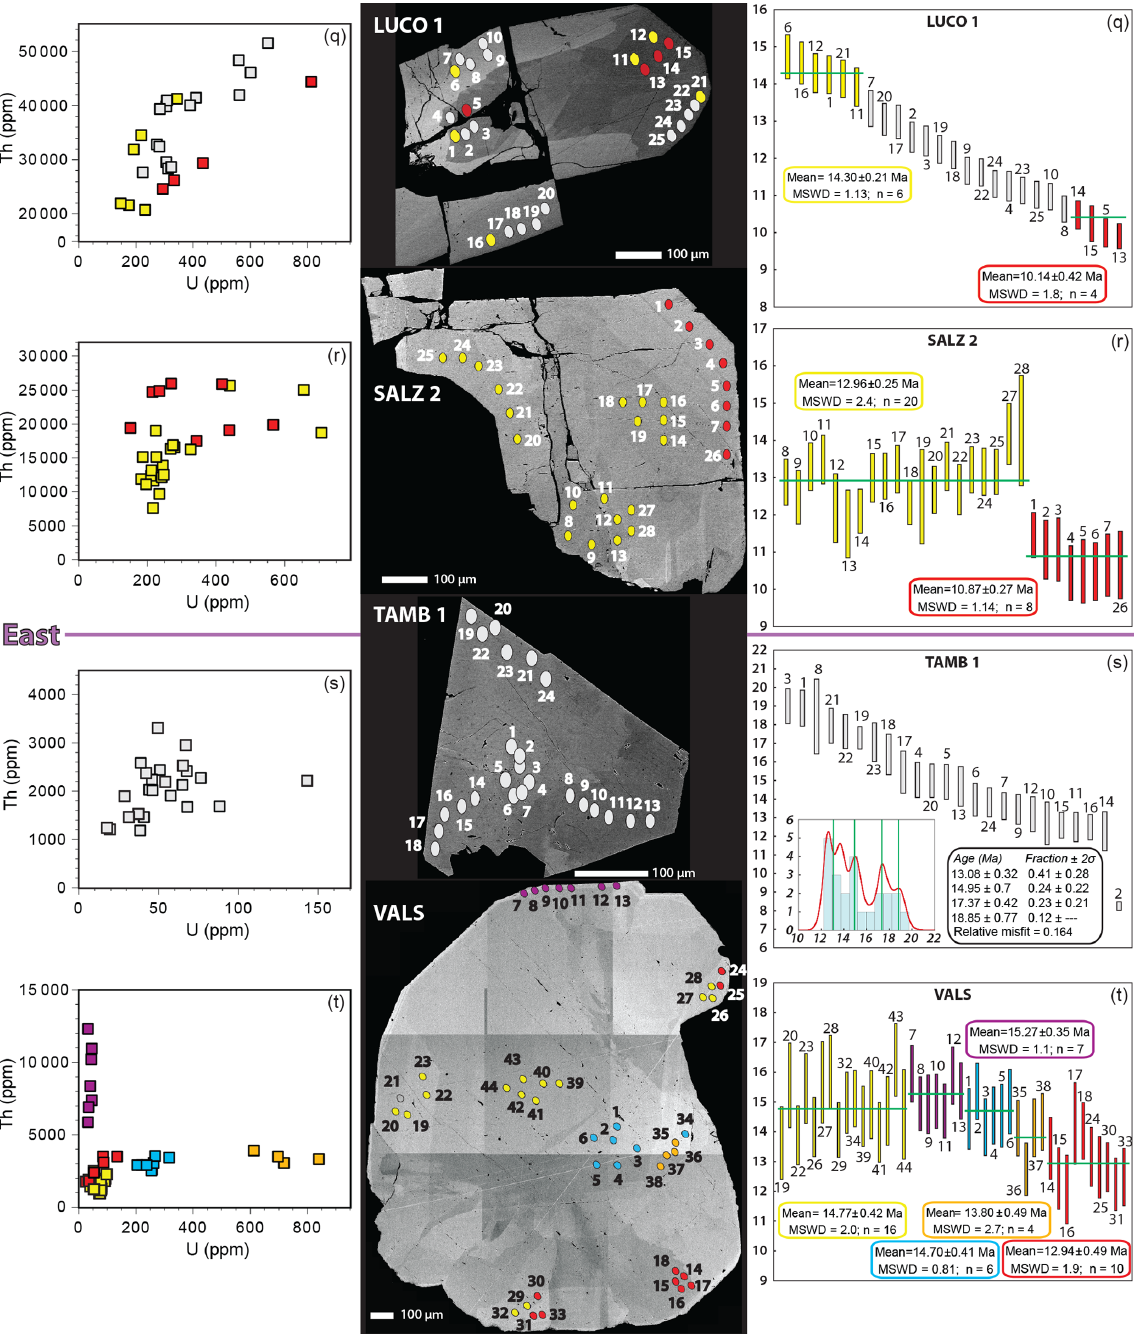
Figure 5. Visualization by sample of all SIMS analyses conducted for this study. Chemical plots that best show the different groups within a sample (left), BSE images (center) with colored ovals representing analysis spots being to scale, and age diagrams (right) show 208 Pb / 232 Th ages. Gray ovals were not included in any of the